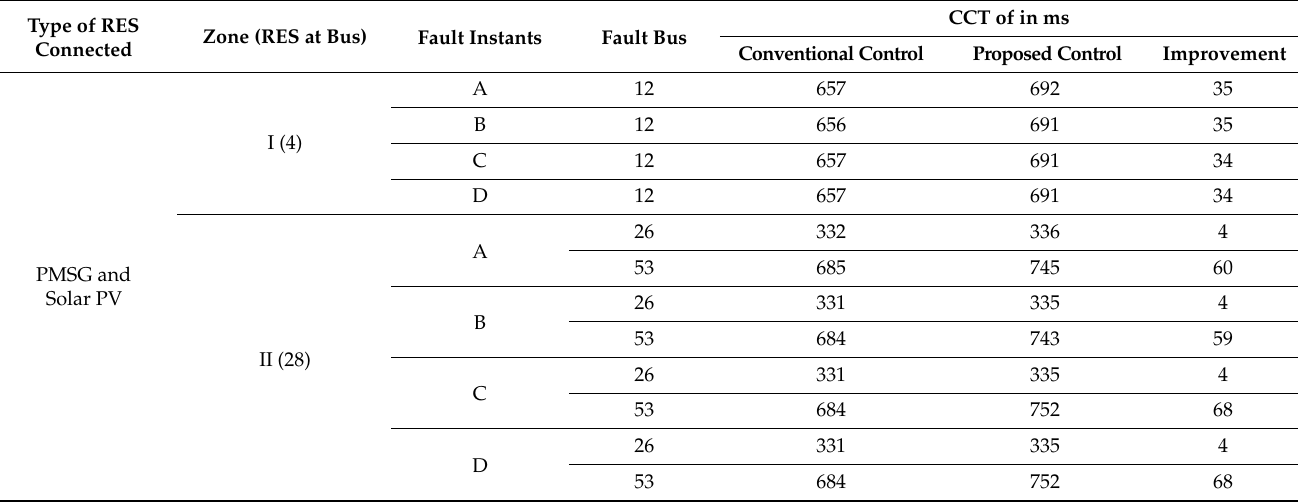
Table 4. CCT when connected to different RES at various fault